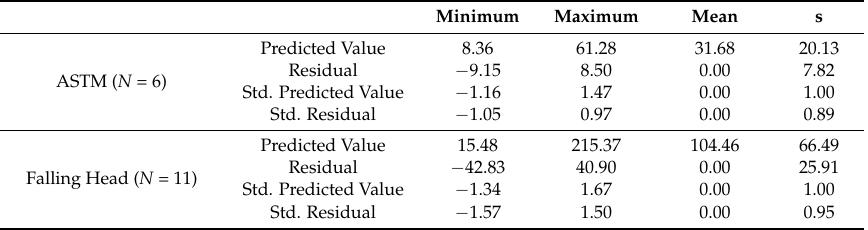
Table 4. Residual statistics for ASTM and falling head regressions given in Equations (2) and (3), respectively.